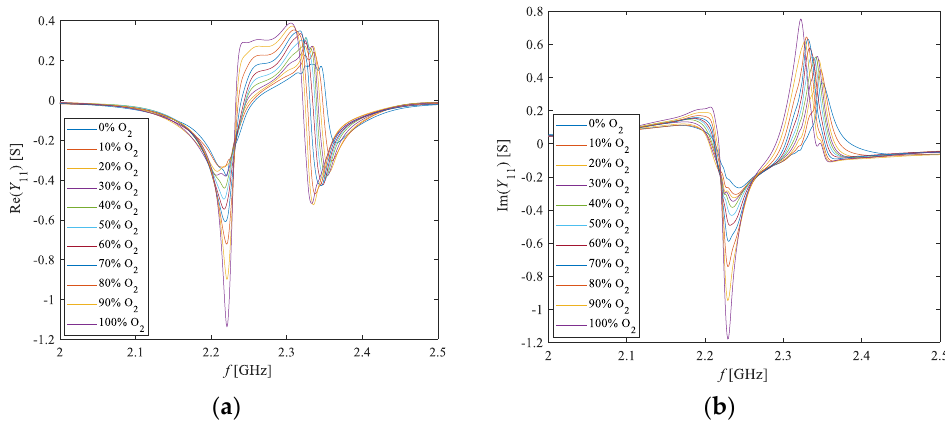
Figure 13. Frequency dependence of the ( a ) real and ( b ) imaginary parts of Y 11 at different O 2 concentrations, spanning from 0% to 100% with a step of 10%. These values are obtained by using the proposed ANN model.